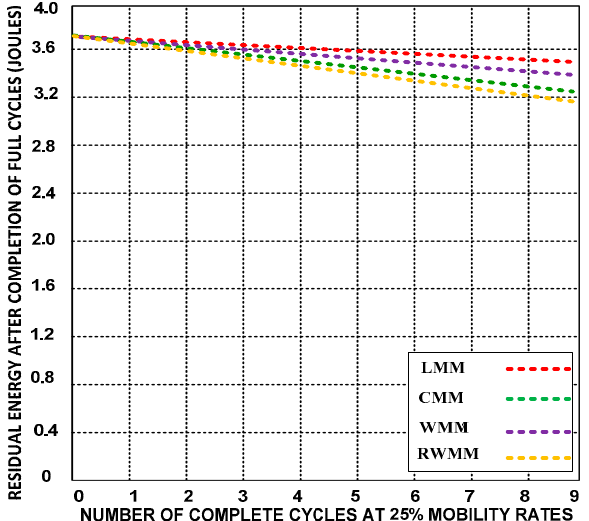
Figure 12. Residual energy after completion of the ninth cycle at 25% mobility rates.